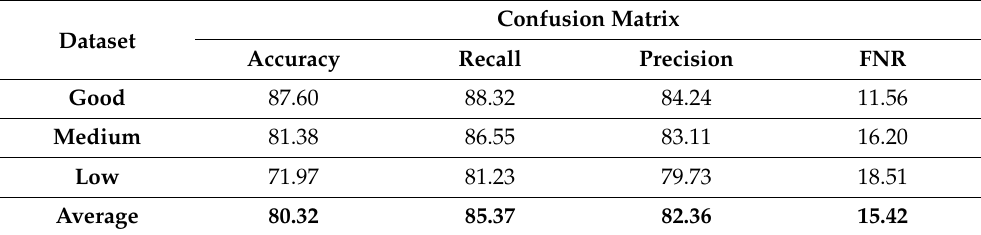
Table 2. Experimental result using confusion matrix.